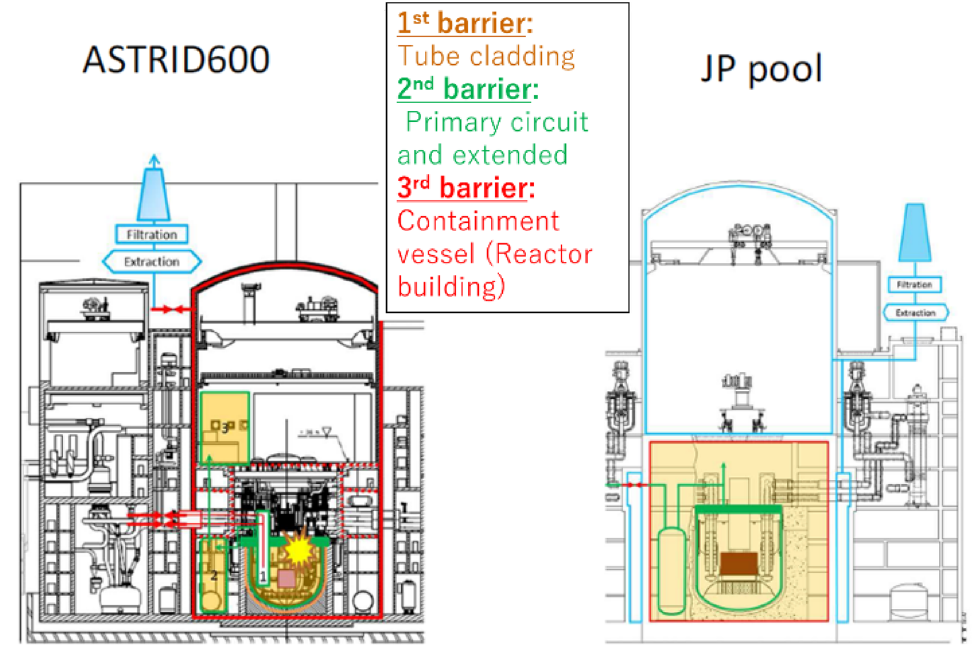
Fig. 12. Concept of